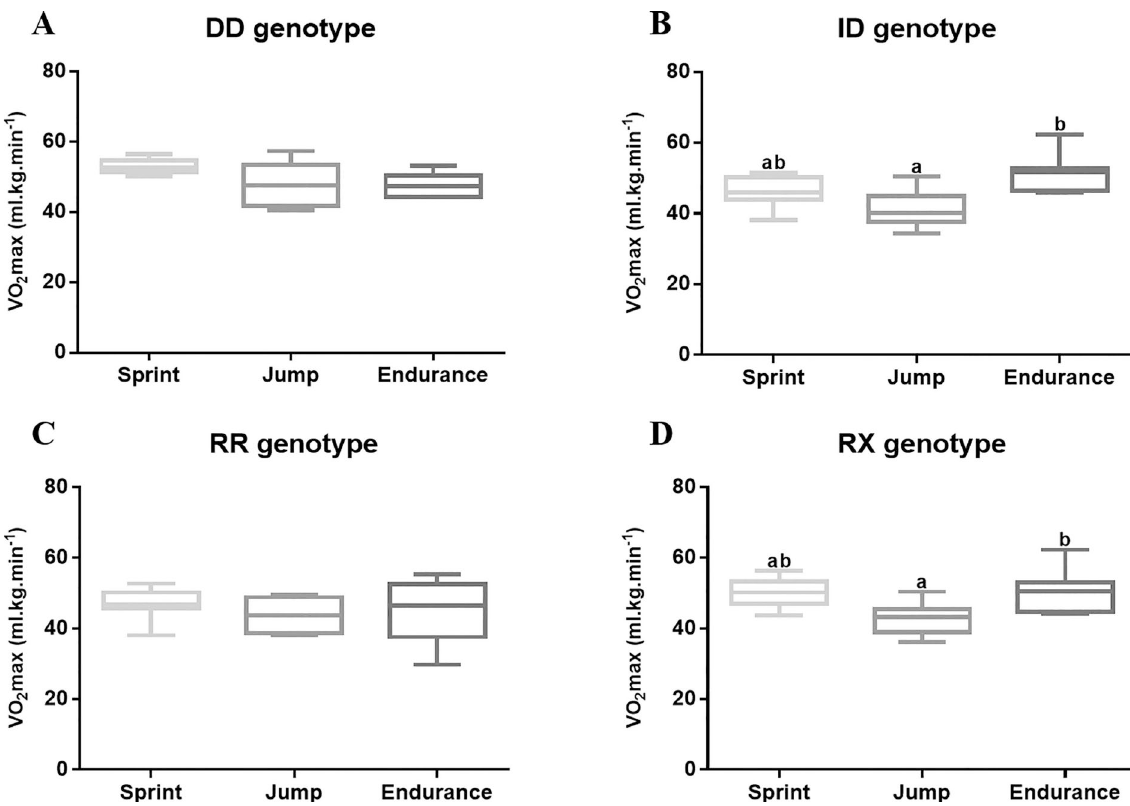
Figure 4 - Effect of ACE and ACTN3 gene variants on VO 2max in young talents. The DD genotype (a), ID genotype (b), RR genotype (c) and RX geno- type (d). Different letters indicate significant differences between groups (one-way test (ANOVA) followed by Tukey's test, p <